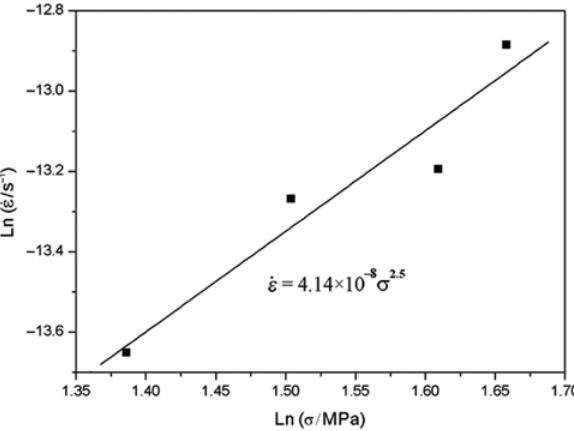
Figure 4: Relationship between steady creep rate and applied